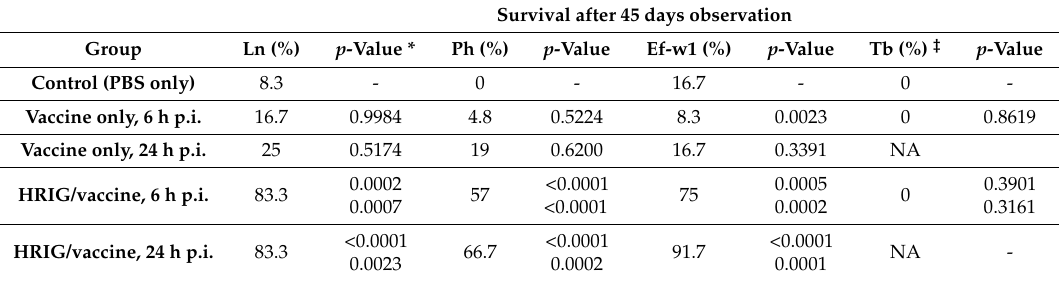
Table 2. Validation of animal model and postexposure prophylaxis (PEP) initiation ( p -values based on log-rank Mantel-Cox test, comparing CL184 with standard PEP regimen 20IU/kg HRIG/vaccine).